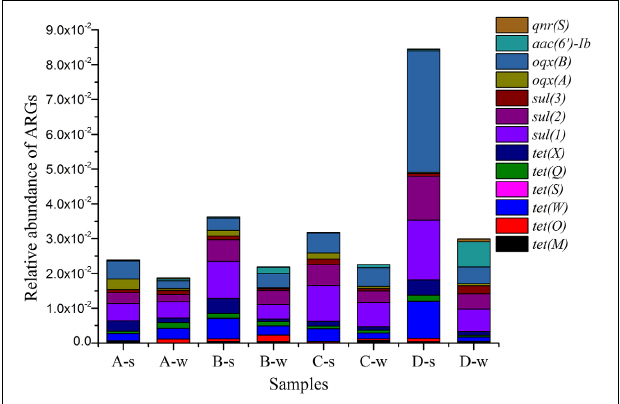
FIGURE 4 | Phylum for bacterial community composition in all